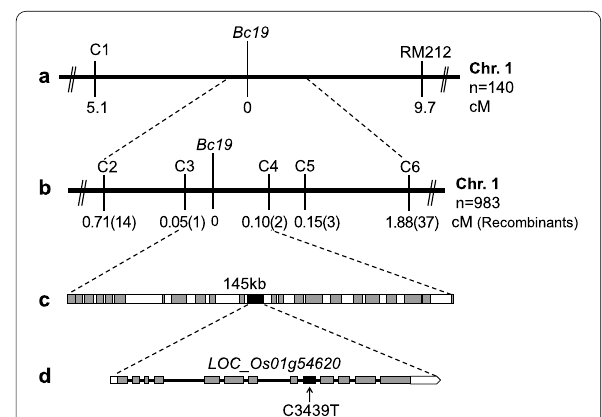
Fig. 4 Molecular mapping of Bc19 locus. a The Bc19 locus was mapped between InDel marker C1 and SSR marker RM212 on the long arm of chromosome 1 (Chr.1) of rice using 140 recessive F 2 plants. b Bc19 was narrowed between InDel markers C3 and C4 depending on analysis of 983 recessive F 2 plants. c 23 annotated genes were found in the 145-kb region between markers C3 and C4. d Structure of the candidate gene Bc19 ( LOC _ Os01g54620 ). Gray boxes indicate exons and lines indicate introns. The C3439T